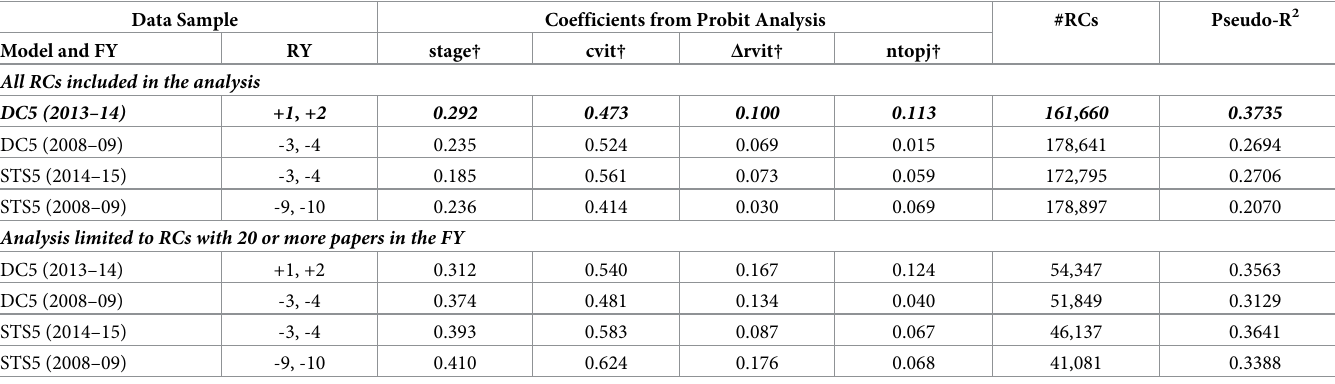
Table 5. Indicator construction using different data